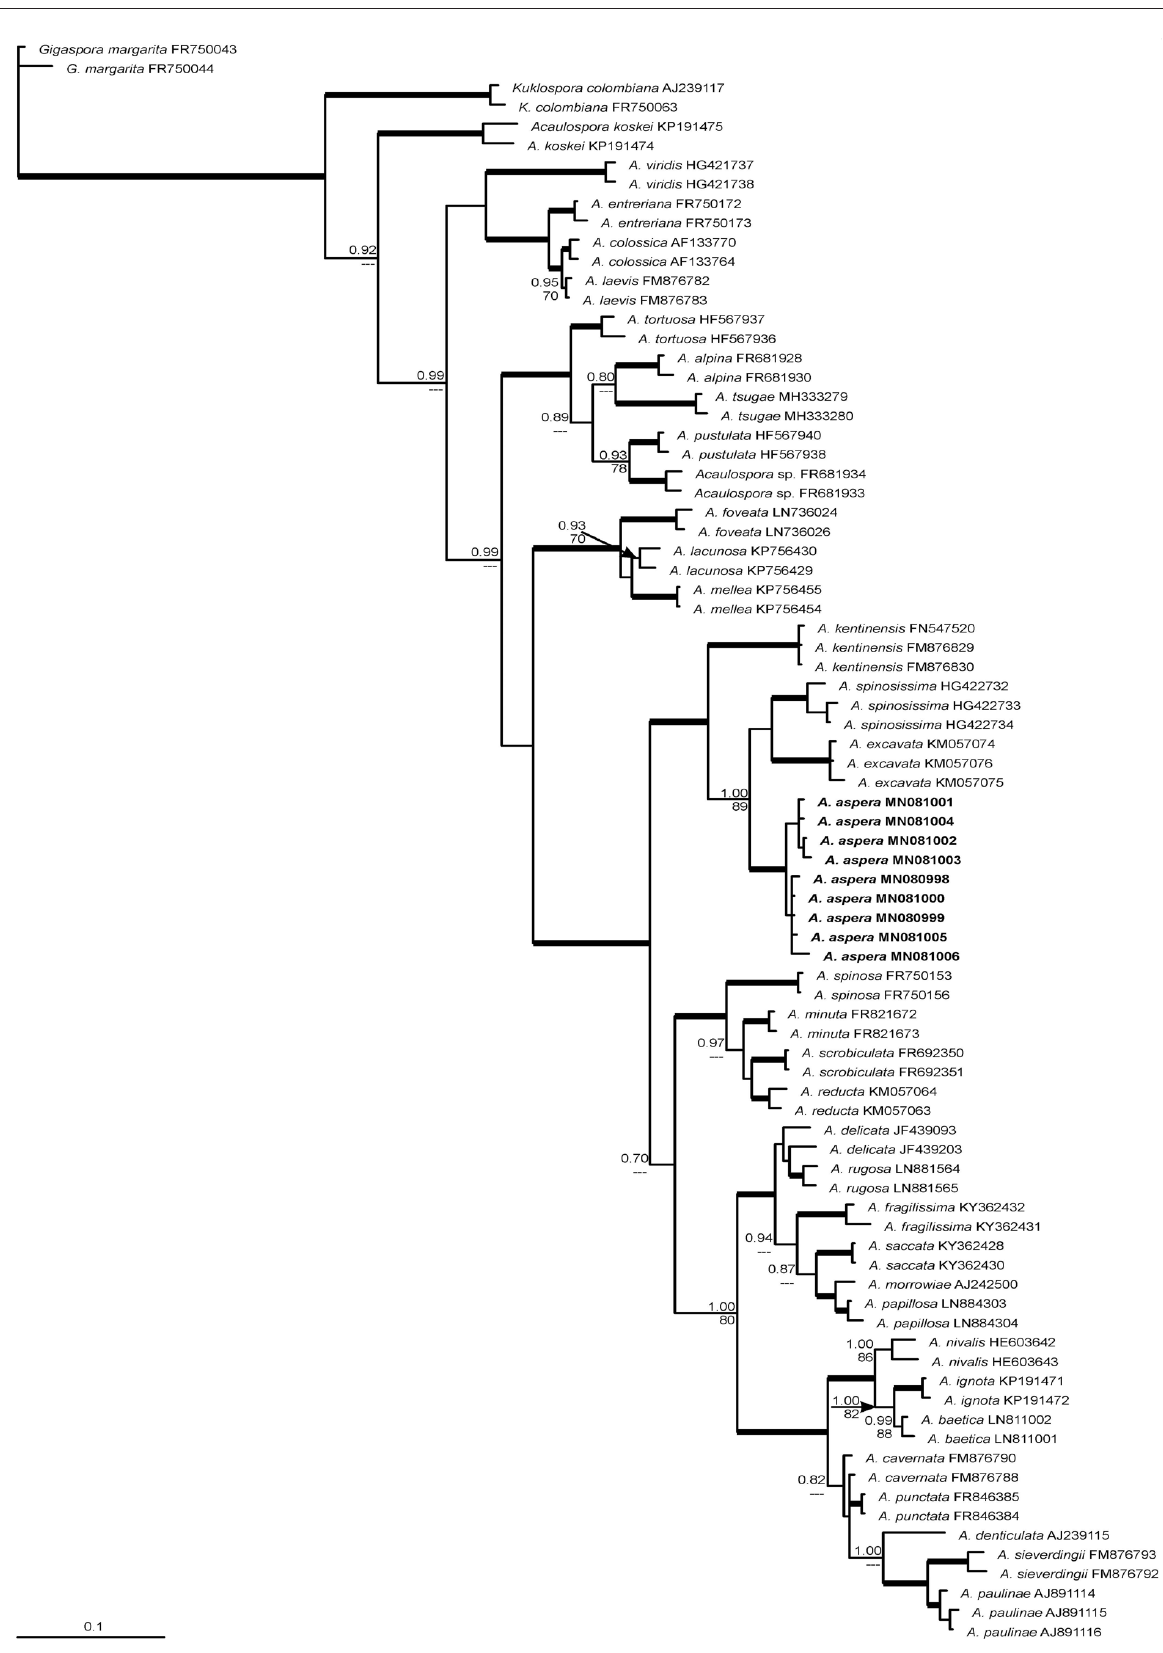
Fig. 18: Phylogenetic tree of the Acaulosporaceae obtained by analysis from sequences of the ITS region of the rDNA from different Acaulospora spp. Sequences are labeled with their database accession numbers. Support values (from top) are from Bayesian inference (BI) and maximum likelihood (ML), respectively. Sequences obtained in this study are in boldface. Only support values of at least 70% are shown. Thick branches represent clades with more than 90% of support in all analyses. The tree was rooted by Gigaspora margarita